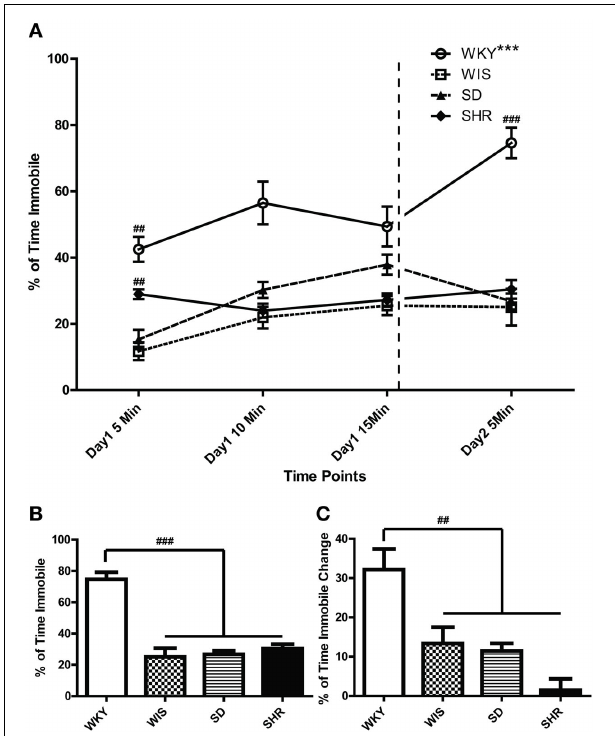
FIGURE 2 | Distinct immobility profile of WKY vs. other strains in the forced swim test. Depressive-like behavior was assessed in adult male Wistar Kyoto (WKY), Wistar (WIS), Sprague–Dawley (SD), and Spontaneously Hypertensive (SHR) rats using a standard 2-day Porsolt forced swim test. The first day involved a 15-min swim session; 24h later, rats were subjected to a second 5-min swim session. Percent time spent immobile was averaged over 5-min bins during the 2 days of the test (A) . Average percent immobility on Day 2 vs. average on Day 1 was significantly greater in WKY rats, but not in the other strains; ∗∗∗ p < 0 . 001 for time effect (Day 1 vs. Day 2; A ). Day 1 immobility scores were significantly different among strains; ## p < 0 . 01 for strain effect (vs. all the other strains; A ). WKY rats were significantly more immobile than the other rat strains on Day 2 ( A,B ; ### p < 0 . 001), and the magnitude of change in immobility during the first 5min. bin on Day 1–2 was significantly greater in WKY rats ( C ; ## p < 0 .